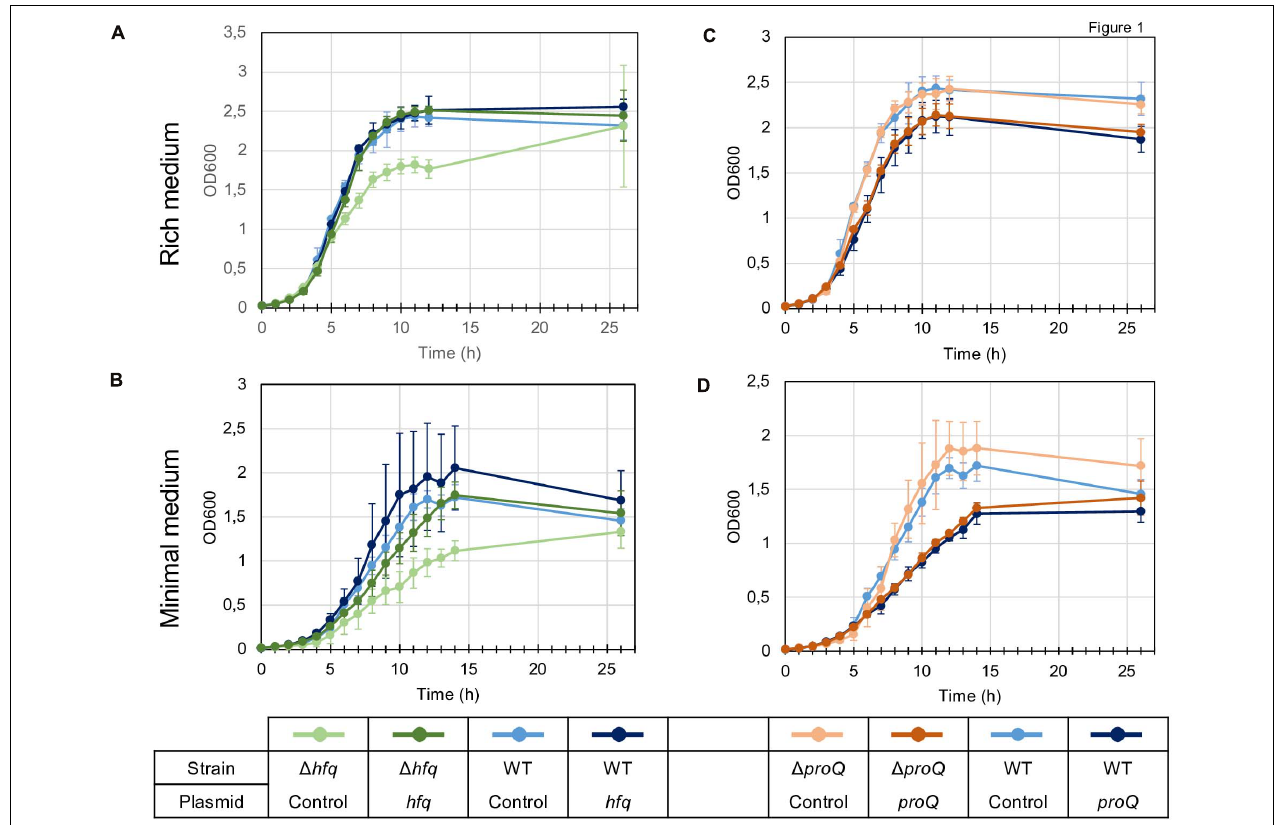
FIGURE 1 | Growth of the wild type, mutant and complemented strains in LB rich medium (A,C) and M63 minimal medium supplemented with sucrose (B,D) . Overnight bacterial precultures were diluted to an OD 600 of 0.03 in the same growth medium. OD 600 measurements of the culture were made at regular intervals to determine growth rates. The experiment was repeated three times. The graph shows curves from one representative experiment. Error bars represent deviation of biological